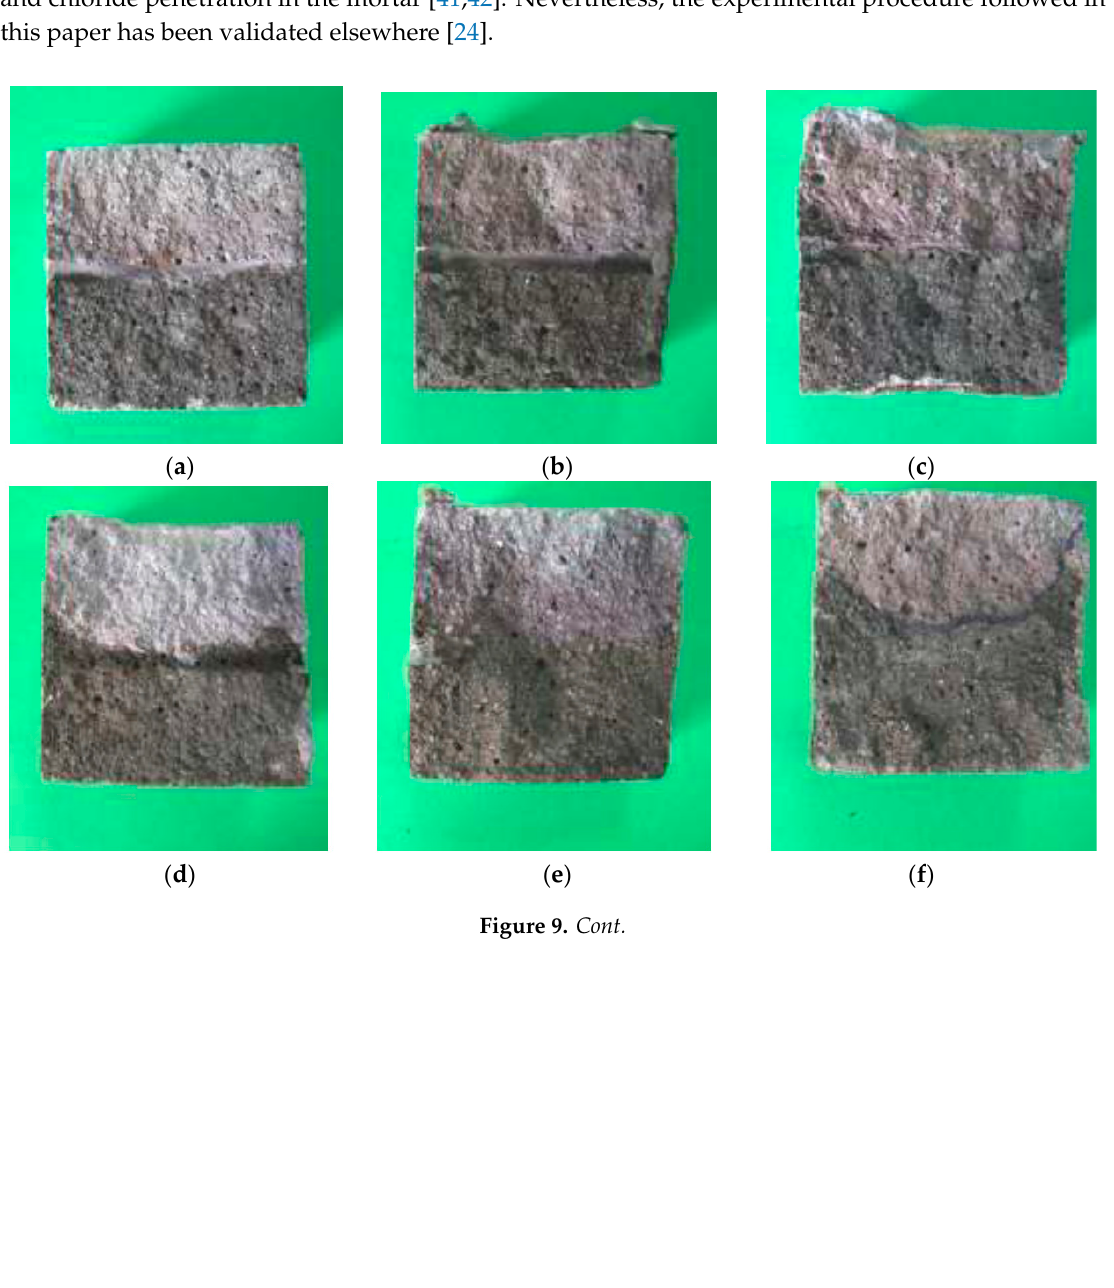
Figure 8. Relationship between I corr and E corr during the transition from a passive to an active state. Data of all the samples are considered before and after